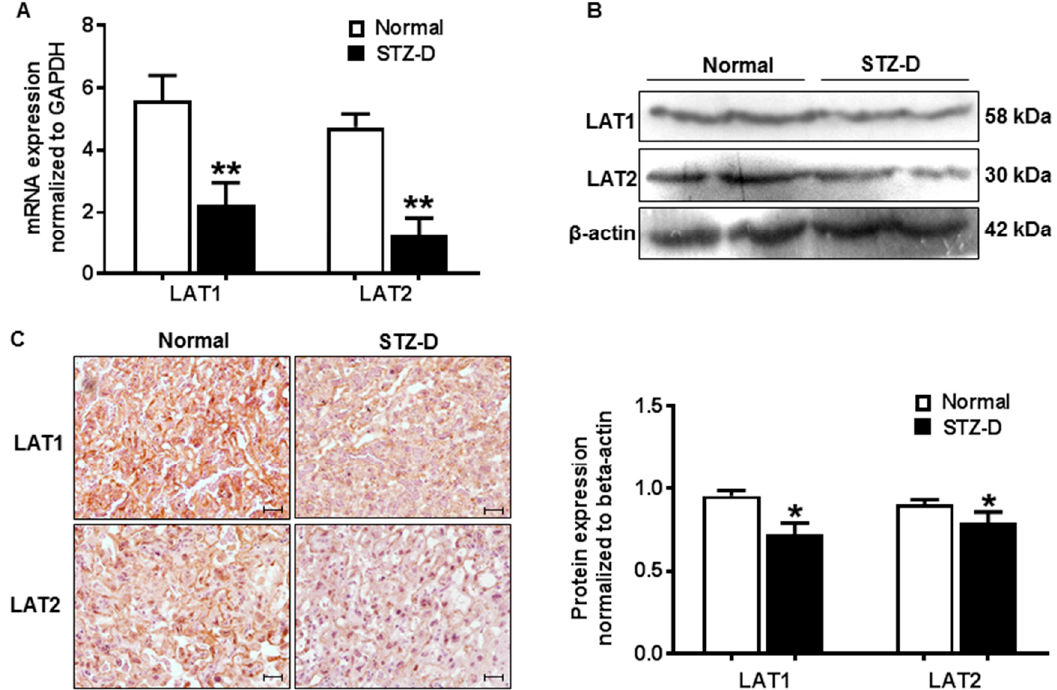
Figure 2. Pregestational diabetes resulted in decreased placental amino acid transporter expression in STZ-D rats. ( A ) Relative mRNA expression of system L amino acid transporter LAT1 and LAT2 detected by quantitative-PCR in placentas derived from normal and STZ-D pregnant rats ( n = 3). ( B ) Expression of LAT1 and LAT2 detected by Western blots in placentas from normal and STZ-D rats. The bar graph shows the relative density of protein expression for LAT1 and LAT2 after normalization with β -actin expression in each sample. Data are mean ± SD from six normal and six STZ-D placentas. * p < 0.05, ** p < 0.01, normal versus STZ-D. ( C ) Representative immunostaining images of LAT1 and LAT2 expressions in tissue sections from normal and STZ-D placentas. Scale bar, 250 μ m.